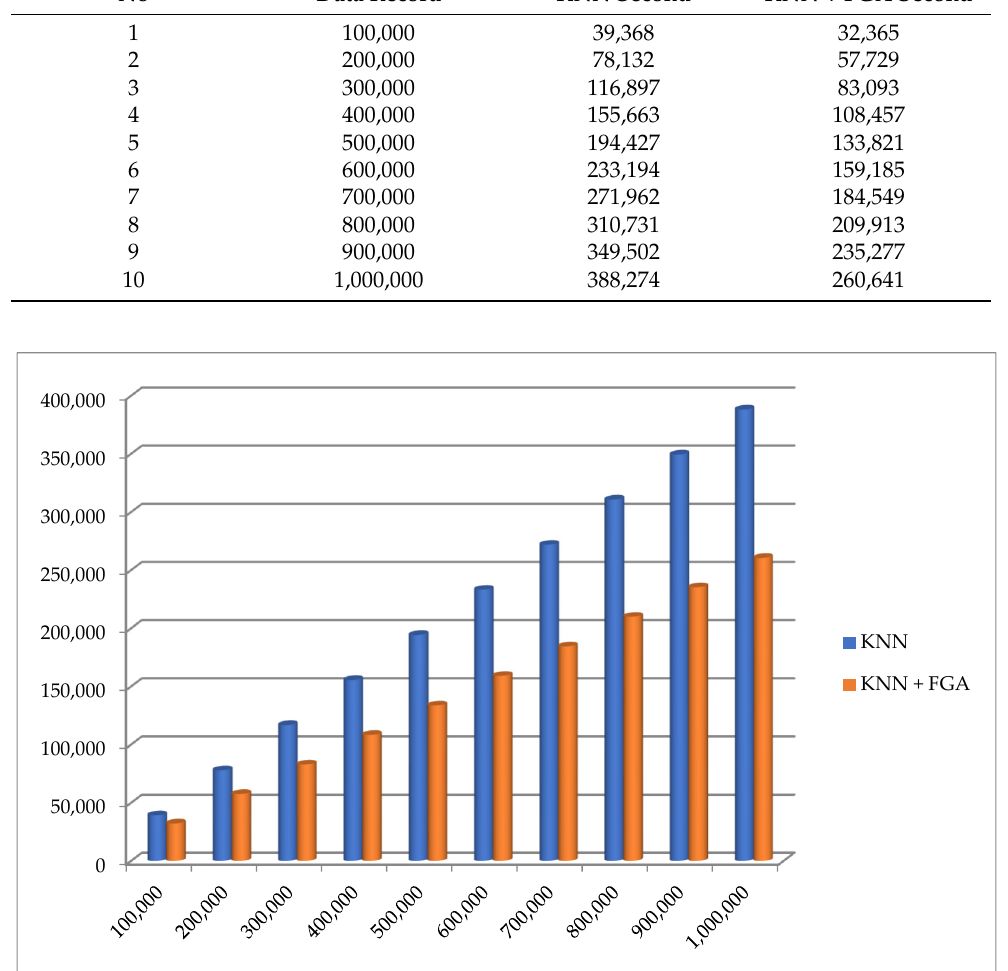
Figure 5. Graph of computational performance of KNN and KNN using FGA.